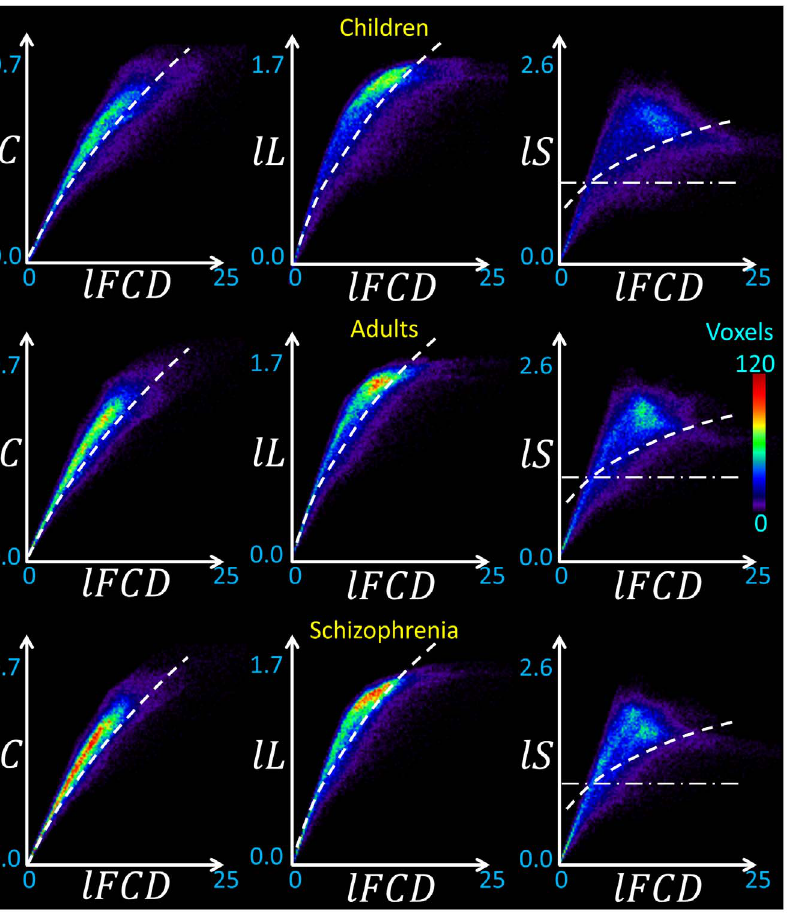
Figure 5. Voxelwise association between graph-theory measures. Two-dimensional histograms (probability distributions) corresponding to (non-linear) relationships between voxelwise measures of l FCD, lC , lL and lS , averaged across children (N = 40), adults (N = 74) and schizophrenia patients (N = 69). The color maps (frequency) reflect the number of voxels within each of the 128 6 128 uniform 2d-intervals (bins). Dashed lines reflect the power scaling in Fig 3. The dash dot line indicates the boundary of the small-world topology ( lS = 1). Correlation thresholds: R T1 = 0. 50; R T2 = 0.65.